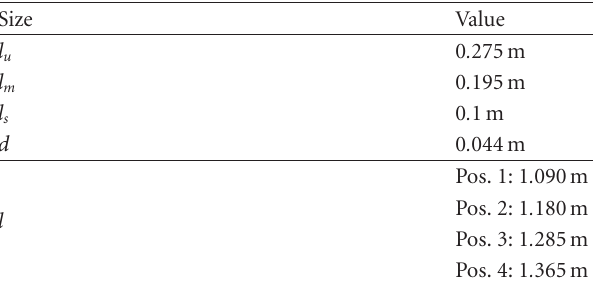
Table 1: Dimensions of the Rijke tube